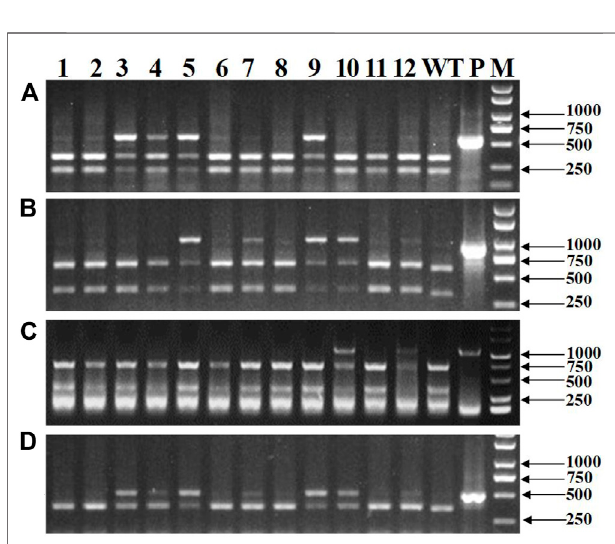
FIGURE 6 | Detection of mutations of wheat TaNud genes by PCR-RE assay using speci fi c primers and the conservative primers. (A) TaNud - 7A